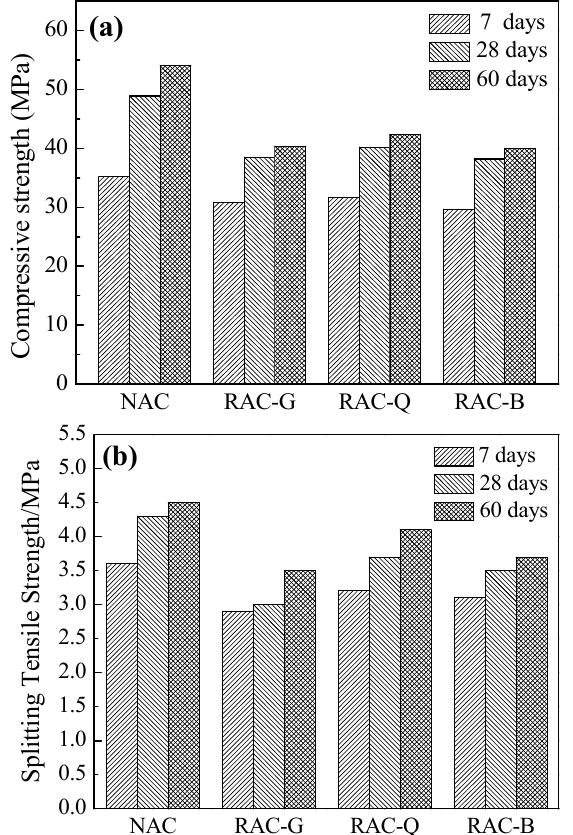
Figure 7. Compressive strength of concrete ( a ) and splitting tensile strength of concrete ( b ). In Figure 7a, since the coarse aggregate of RAC-G, RAC-Q and RAC-B was recycled coarse aggregate and contained certain crushed brick particles, and the crushing index value was larger, thus the compressive strength of RAC-G, RAC-Q and RAC-B was smaller than that of NAC. In the three groups of brick–concrete recycled coarse aggregate concrete, the compressive strength of RAC-G and RAC-B at each age was lower than that of RAC-Q, indicating that the water saturated and dry state were more detrimental to the compressive strength of concrete compared to the air-dried state. The results of the 7 days, 28 days and 60 days splitting tensile tests in Figure 7b are similar to the compressive strength law, which also shows that the incorporation of all three water-content states of recycled aggregates reduced the splitting tensile strength of the concrete, with the air-dry state of the RAC-Q group having the least adverse effect on the 28 days and 60 days splitting tensile strengths. The reason that the additional water quantity of RAC-G was extremely greater than that of RAC-Q, which increased the effective W/B. Furthermore, the early rapid water absorption of recycled aggregate caused low W/B in the interface zone, which made the ITZ structure loose and porous (see Figure 6b) and lead to a reduction in strength. Owing to the “water release effect” of the saturated coarse aggregate in RAC-B, the W/B of ITZ was increased, and the hardness and elastic modulus of ITZ was reduced, thus affecting the strength of concrete.